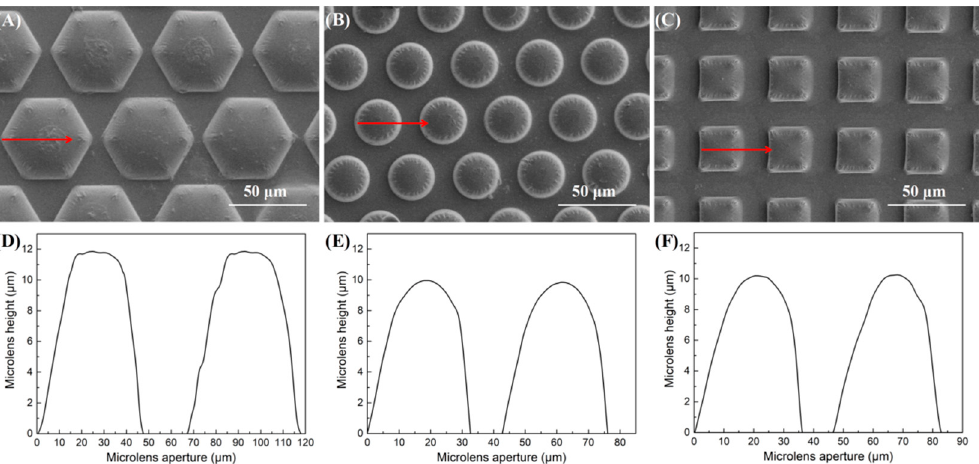
Figure 4. The SEM images and corresponding outlines of the ( A , D ) hexagonal MLAs, ( B , E ) circular MLA and ( C , F ) square MLA built on the silicon solar cells’ surface; the length of the red arrows in the SEM images is 45.5 µm.